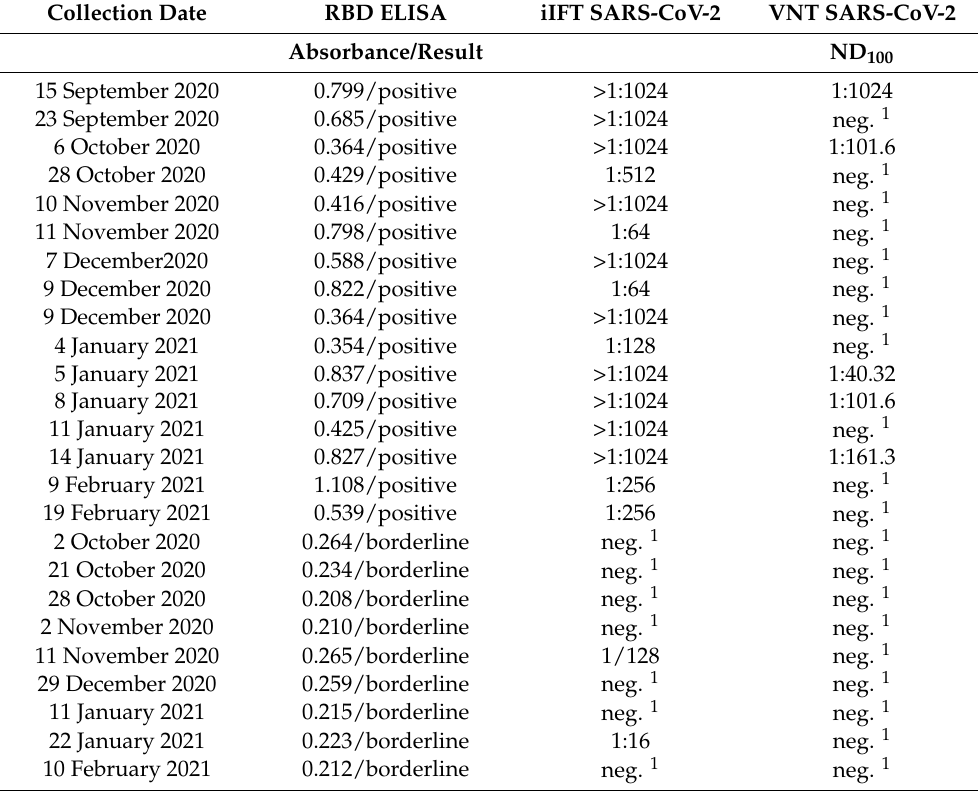
Table A1. Results of the indirect ELISA against the RBD of SARS-CoV-2, as well as of the virus neutralization test (VNT) and the indirect immunofluorescence assay (iIFT) against